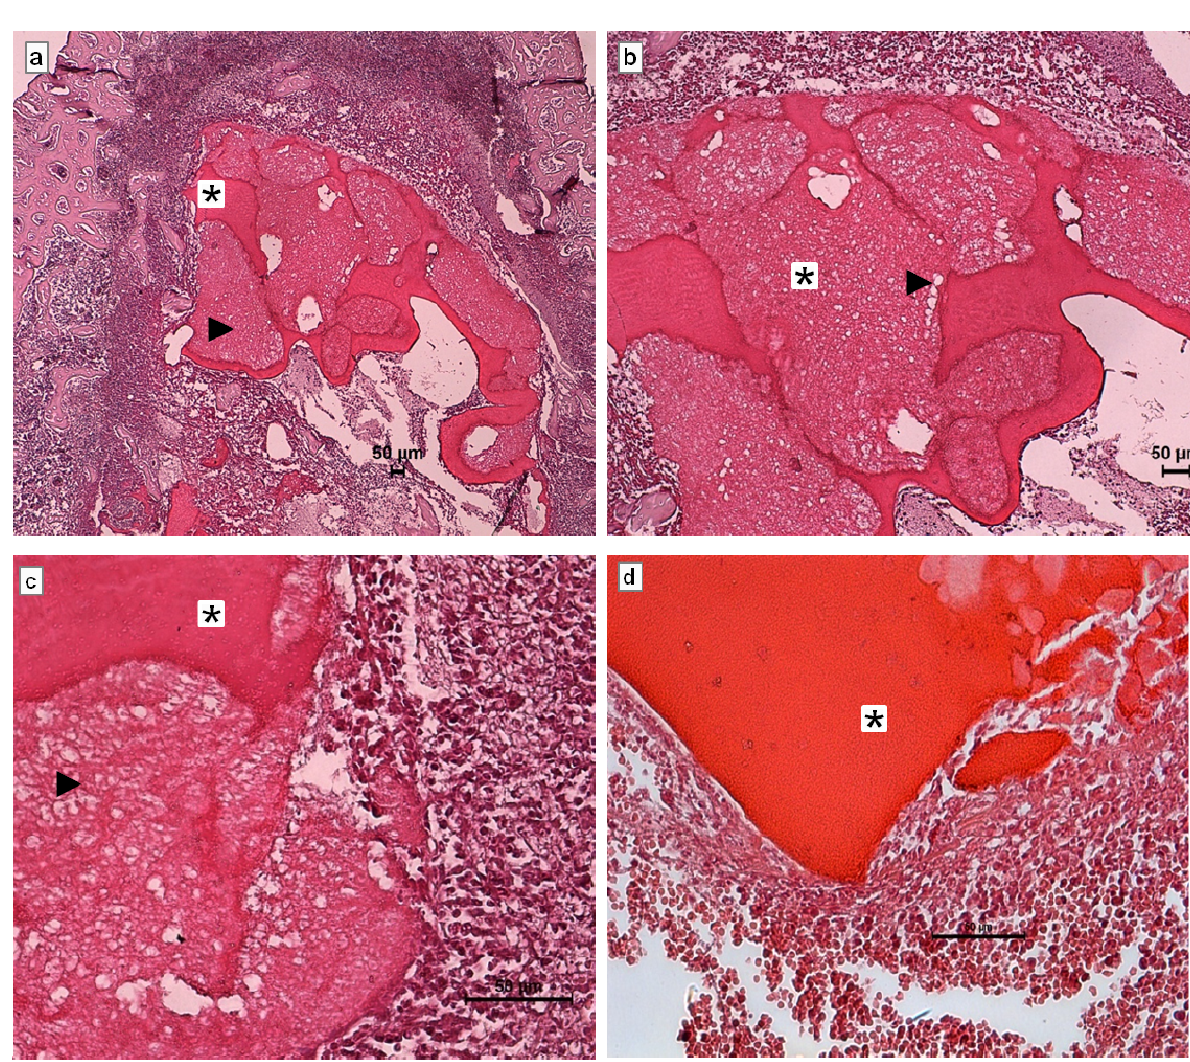
Figure 7. Histological evaluation of CS/Sol-Si biocomposite and pure chitosan (CS) at 1 day post-implantation in the hematopoietic bone marrow compartment. ( a – c ) Show the biocomposite composed of chitosan (*) and the silica particles ( ► ). ( d ) shows only CS. All cases show the clot covering the entire surface of the biomaterial. ( a ) Orig. Mag. ×50; ( b ) Orig. Mag. ×100; ( c , d ) Orig. Mag. ×400. H–E stain. CS/Sol-Si ( a – c ). CS ( d ).